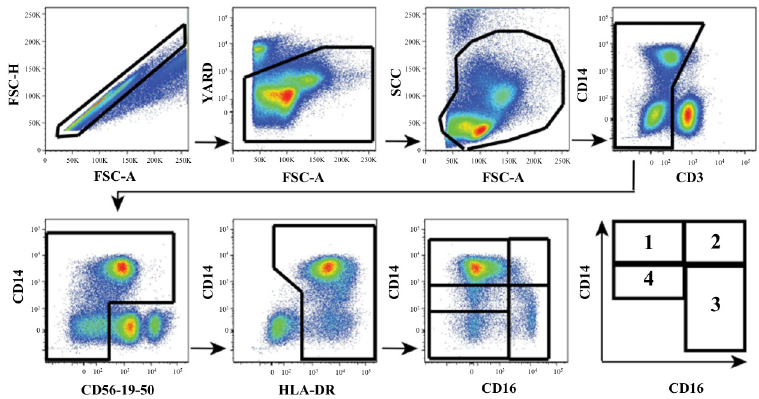
Fig 1. Multiparametric flow cytometry phenotype gating strategy to distinguish distinct monocyte subsets from peripheral blood based on CD16 and CD14 expression. (1) classical monocytes (CD14 ++ CD16 - ), (2) intermediate monocytes (CD14 ++ CD16 + ), (3) non-classical monocytes (CD14 low/+ CD16 ++ ), including (4) “ transitional ” monocytes (CD14 dim CD16 -